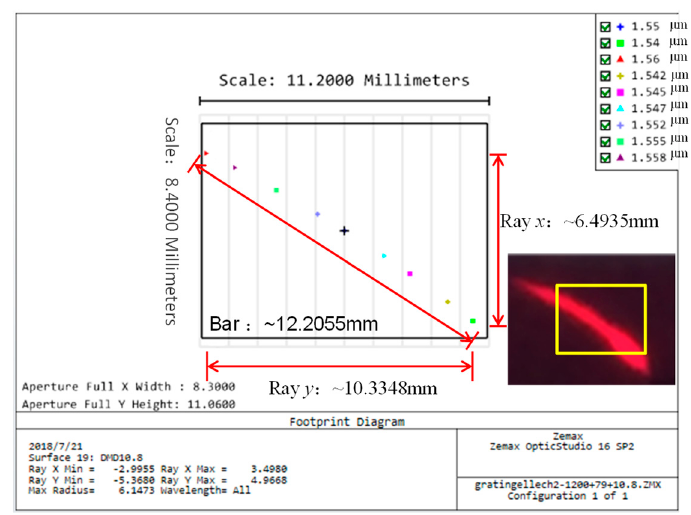
Figure 4. Distribution of the dispersion bar on the digital micromirror device (DMD) surface simulated by Zemax OpticStudio. The inset is the experimental pattern (rectangular box is illustrated as a DMD).